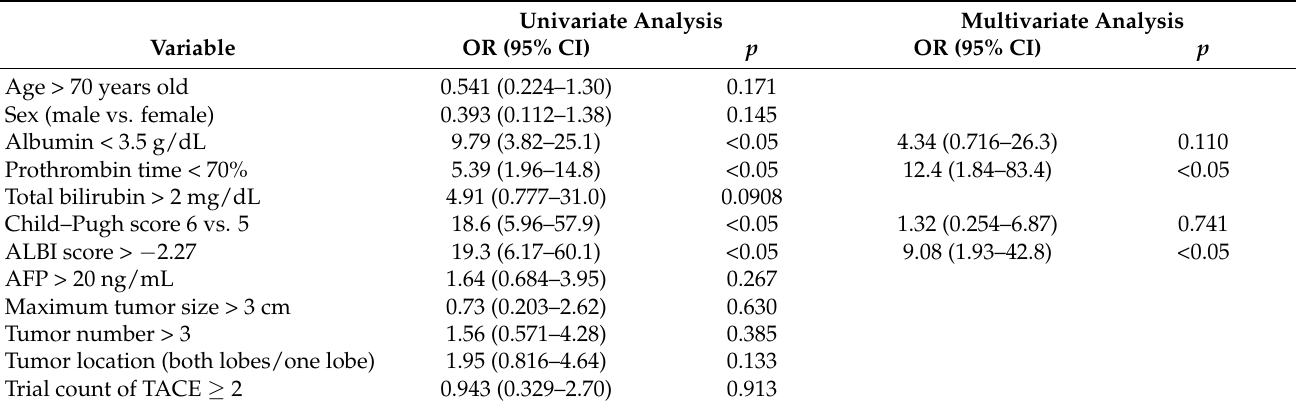
Table 4. Risk factors for liver dysfunction after